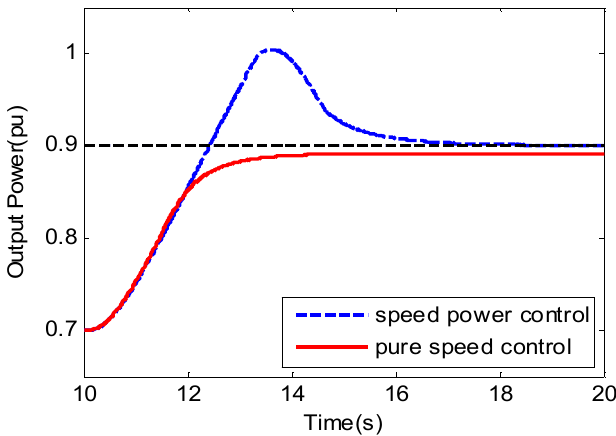
Figure 11. Power response of different control types.